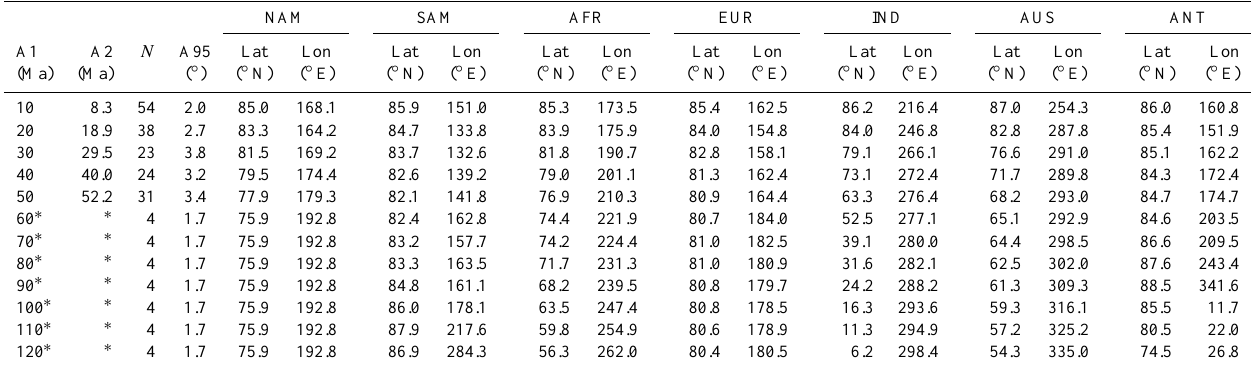
Table 1. APW paths used for paleogeographic reconstructions.